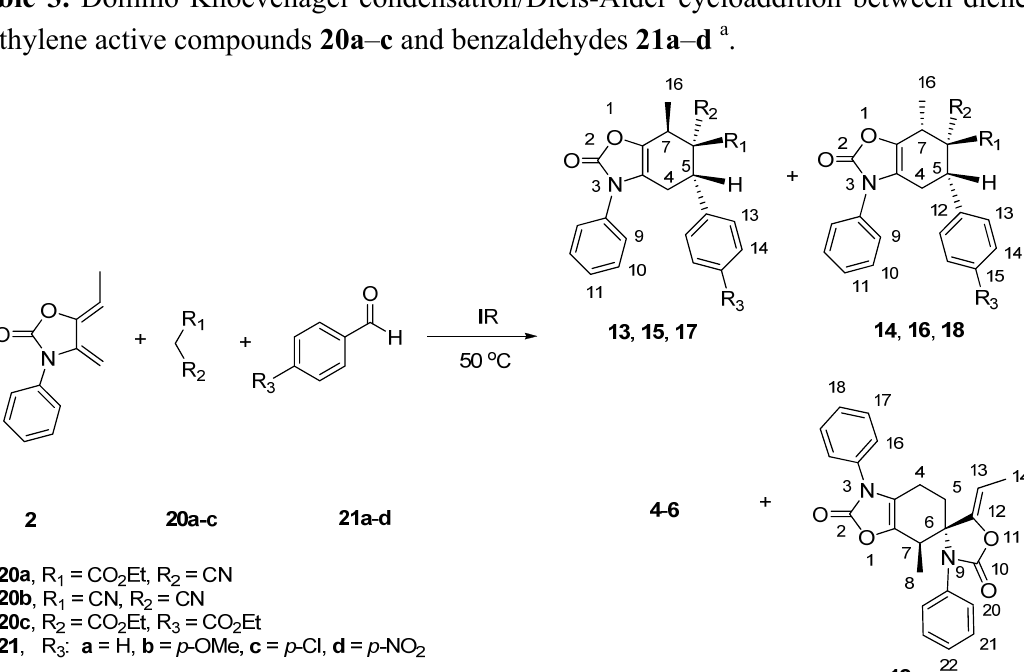
Table 3. Domino Knoevenagel condensation/Diels-Alder cycloaddition between diene 2 , methylene active compounds 20a – c and benzaldehydes 21a – d a